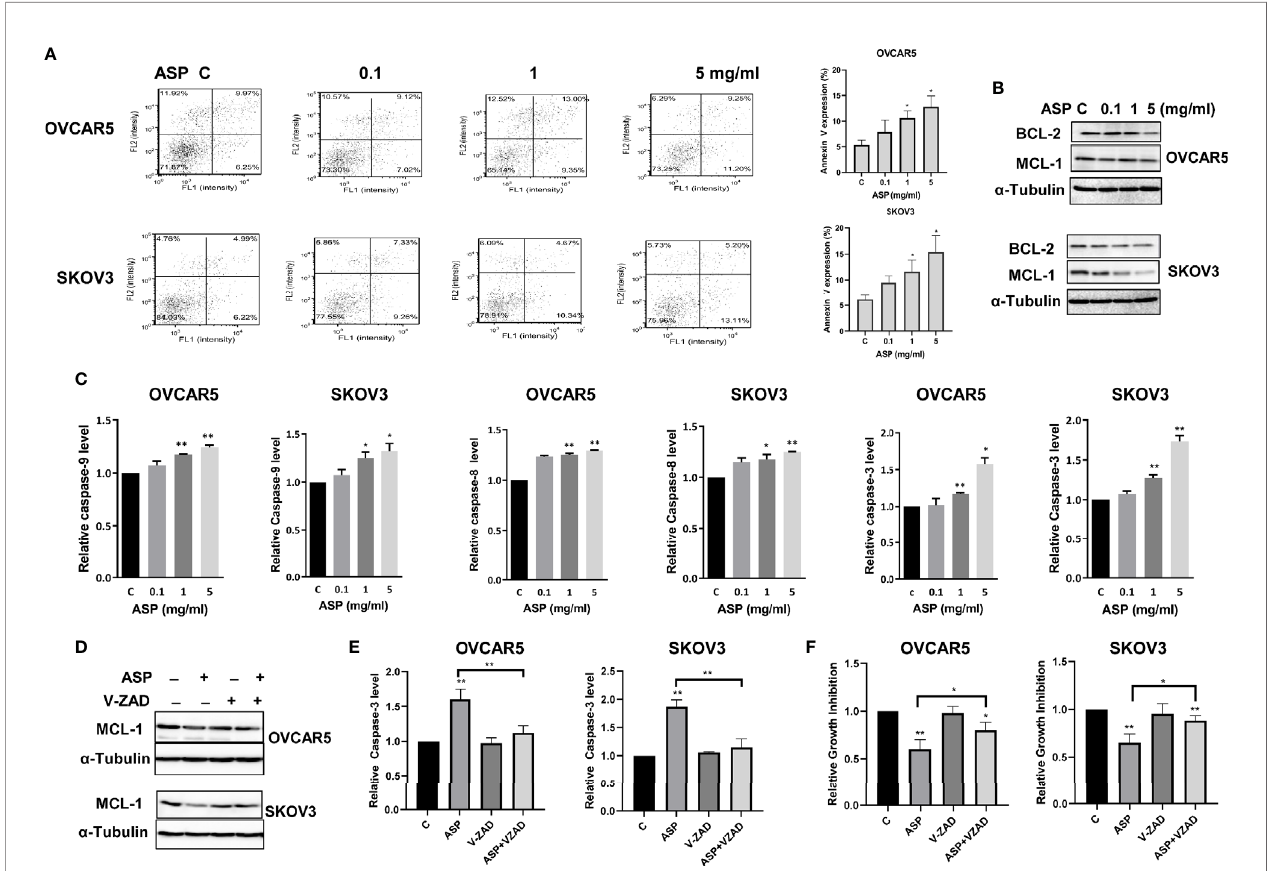
FIGURE 2 | ASP prompted apoptosis in OC cells. ASP increased the expression of Annexin V in the OVCAR5 and SKOV3 cells in a dose dependent manner after 18 hours of treatment (A) . The cells were treated with the indicated concentration of ASP for 24 hours. Western blotting showed that ASP reduced the expression of BCL-XL and MCL-1 in both cells (B) . The activities of cleaved caspase 3, 8 and 9 for the cells treated with different concentrations of ASP were signi fi cantly increased after 14 hours of treatment (C) . OVCAR5 and SKOV3 cells were pretreated with VAD-FMK (10 µM) for 1 hour, followed by treatment with ASP for 18 and 48 hours. Pretreatment with Z-VAD-FMK partially blocked ASP ’ s effects on reducing MCL-1 expression and inducing cleaved caspase-3 activity in both cells (D, E) . Blocking caspase pathways by Z-VAD-FMK in combination with ASP signi fi cantly rescued cell viability (F) . All experiments were repeated three times. *p < 0.05, **p <